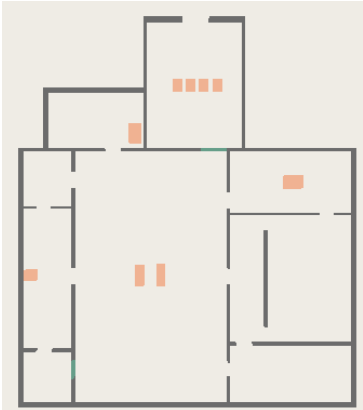
Figure 4: Floorplan of the museum.